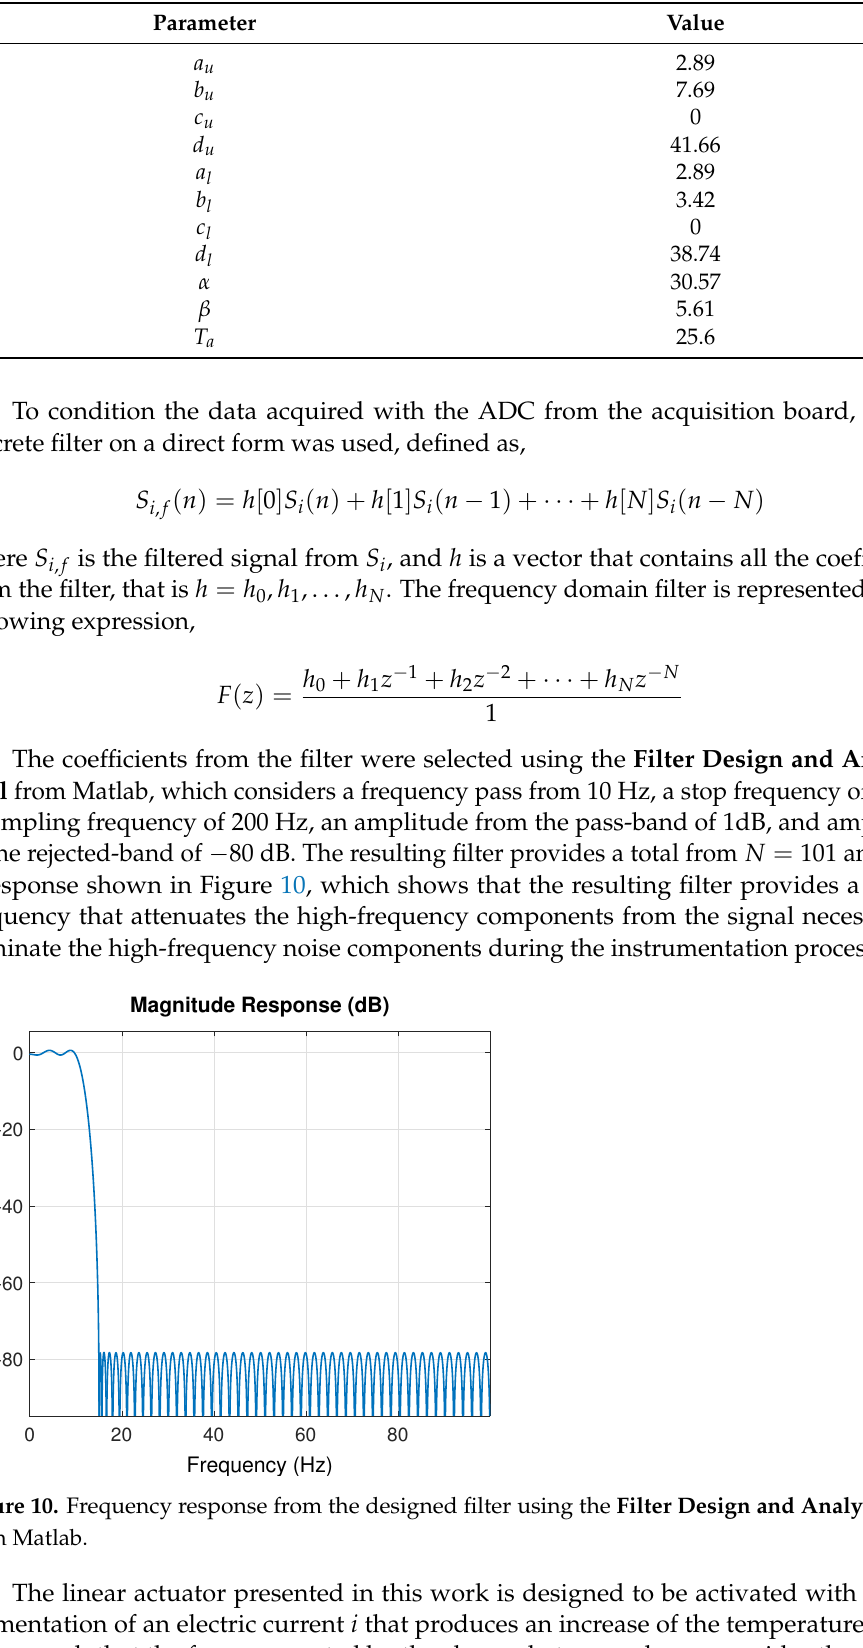
Table 3. Parameters of the SMA springs.